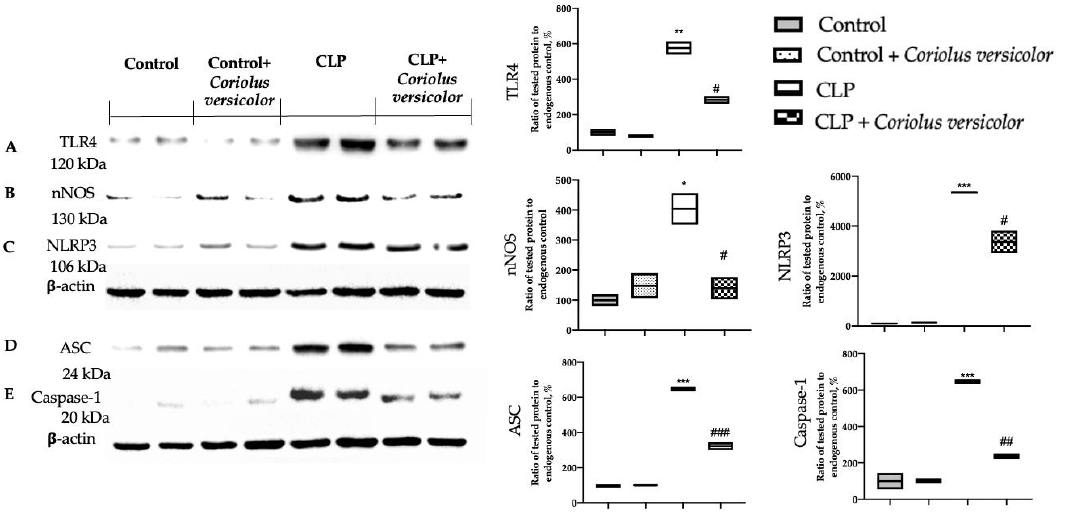
Figure 8. Coriolus versicolor reduced hippocampal inflammation induced by CLP 28 days after surgery. Western blot analysis of toll-like receptor 4 (TLR4) ( A ), nitric oxide synthase (nNOS) ( B ), NLR family pyrin domain containing 3 (NLRP3) ( C ), apoptosis-associated speck-like protein containing a CARD (ASC) ( D ), Caspase-1 ( E ) expression. * p < 0.05 vs. control, # p < 0.05 vs. CLP, ** p < 0.01 vs. control, ## p < 0.01 vs. CLP, *** p < 0.001 vs. control, ### p < 0.001 vs. CLP.